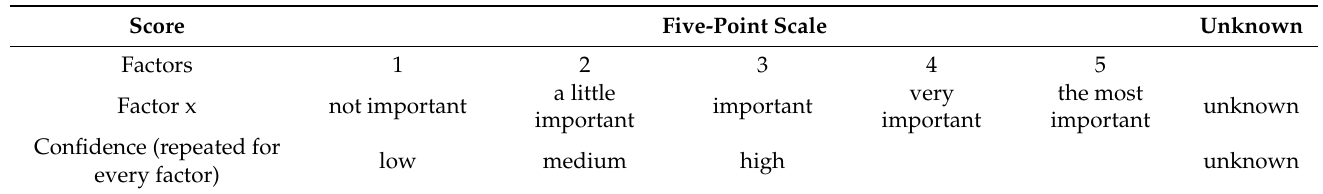
Table 2. Scoring system used during scoring, with importance and confidence level assigned for each factor being monitored through honeybee colony